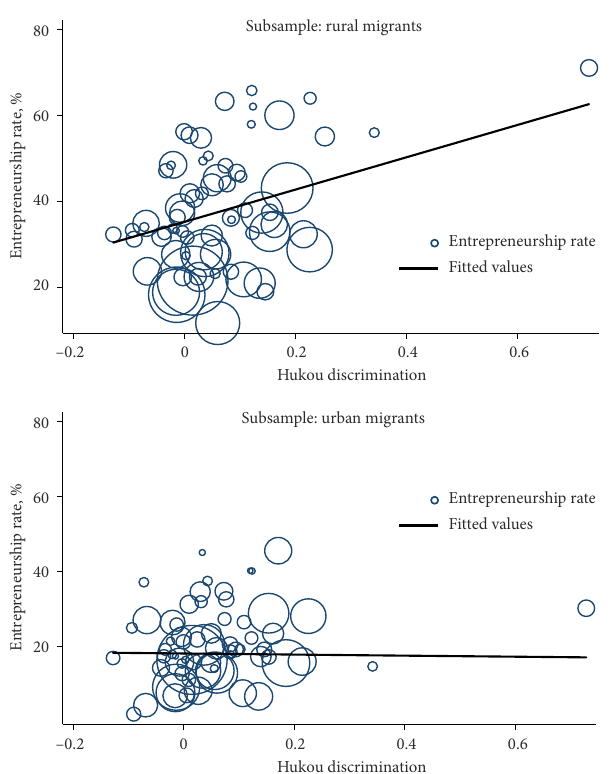
Note : City-level hukou discrimination is measured by the city-level average unexplained part of Blinder-Oaxaca decomposition of individual income between rural and urban migrants. Figure 2. City-level hukou discrimination and migrant entrepreneurship (rural vs. urban migrants) (source: National Health Commission of China,